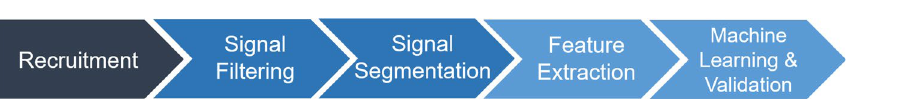
Figure 6. The experimental process of this study. After the fNIRS signal is obtained, it will be filtered, segmented and extracted and imported to machine learning to get classification results, and finally confirm the credibility of the results with